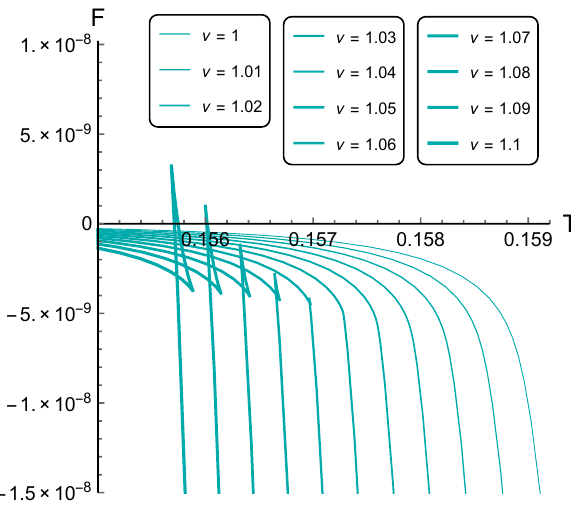
Figure 14 . Free energy as function of temperature F ( T ) for µ = 0 in isotropic ( ν = 1 ) and slightly anisotropic ( ν = 1 . 01 , 1 . 02 , 1 . 03 , 1 . 04 , 1 . 05 , 1 . 06 , 1 . 07 , 1 . 08 , 1 . 09 , 1 . 1 ) cases; a = 4 . 046 , b = 0 . 01613 , c = 0 . 227